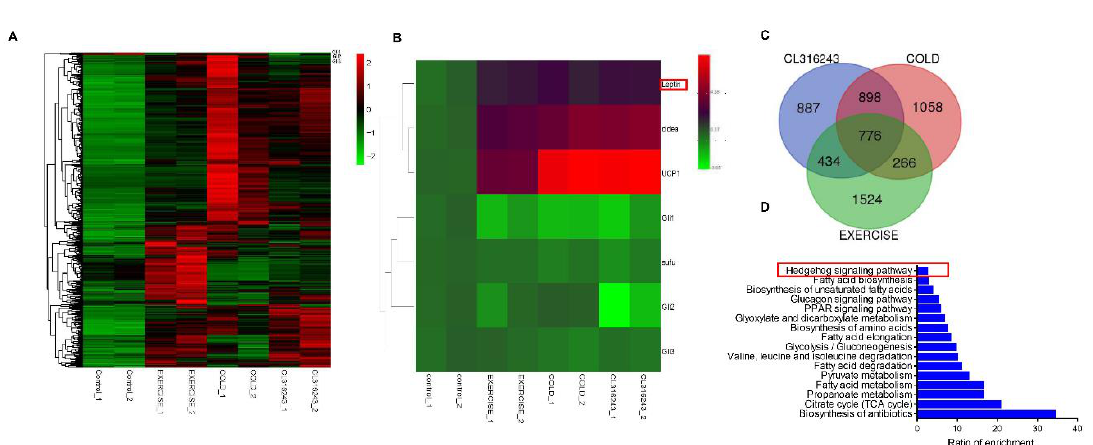
Figure 1. Leptin may induce white adipose browning through the Hh signaling pathway. ( A ) Heat map summarizing expression patterns of mRNA and the Hh signaling pathway regulated by browning induction. ( B ) Heat map of mRNA expression patterns of browning adipose, leptin, and the Hh signaling pathway regulated by browning induction. ( C ) Venn diagram analysis of overlap between the significant differential expression of mRNA (false discovery rate (FDR) ≤ 0.05 and absolute log2FC ≥ 1). ( D ) KEGG pathway enrichment analyses were applied based on any two groups.